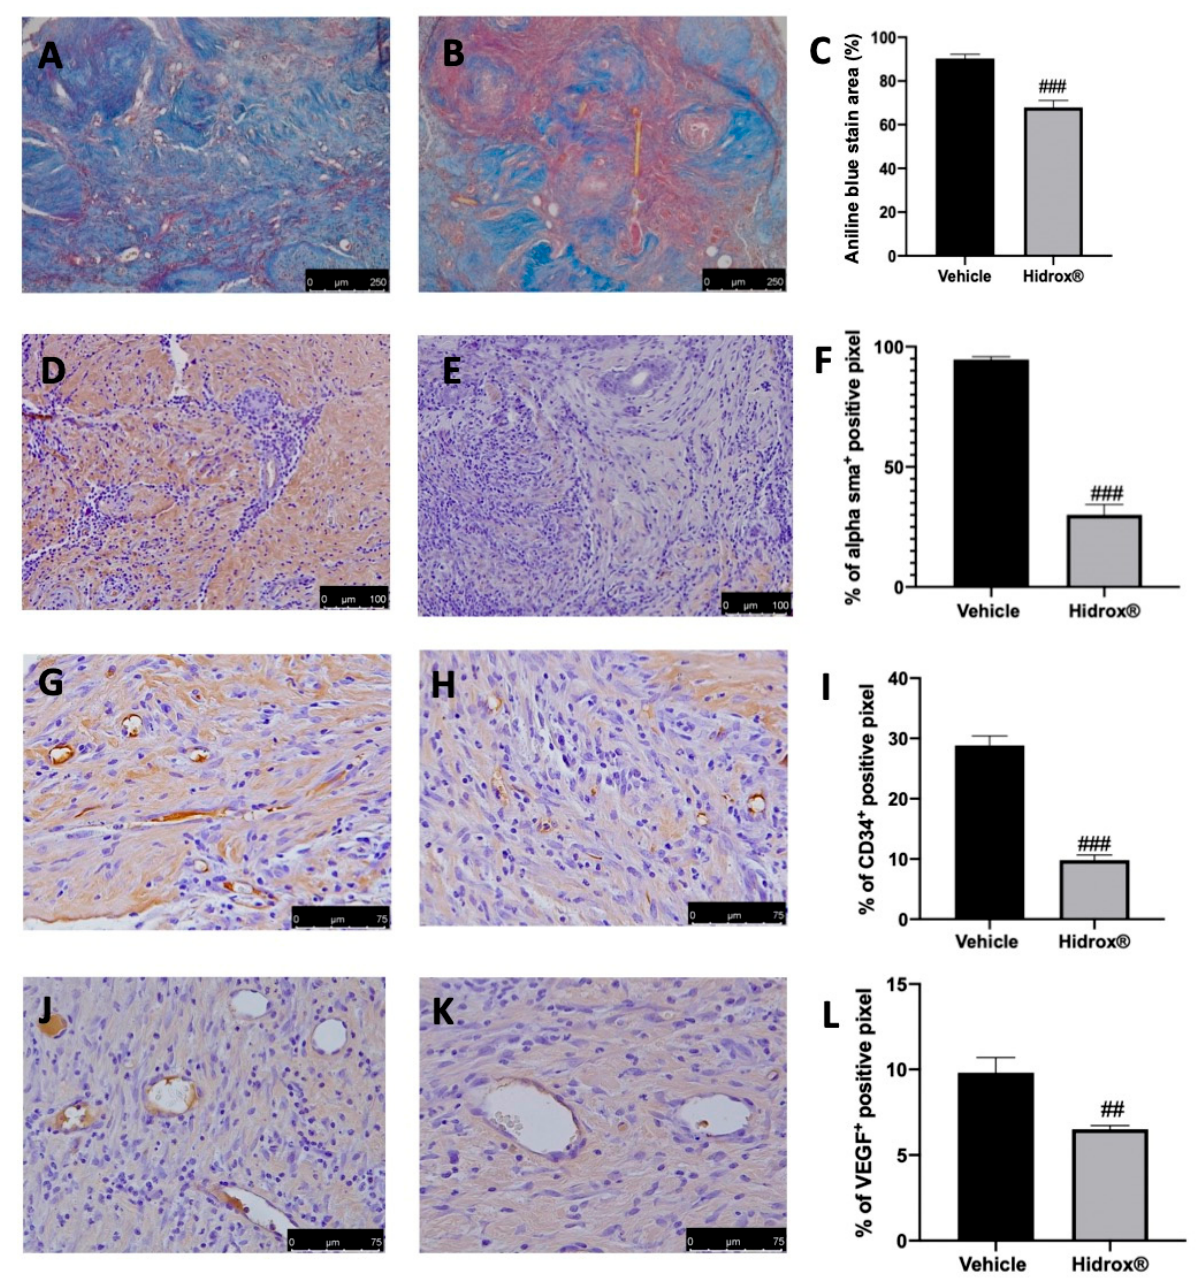
Figure 2. Hidrox ® administration reduced fibrosis and angiogenesis endometriosis-induced: Masson trichrome staining: vehicle ( A ), Hidrox ® ( B ), aniline blue stain area ( C ); immunohistochemical analysis of α -sma: vehicle ( D ), Hidrox ® ( E ), graphical quantification of α -sma expression ( F ); immunohistochemical analysis of CD34: vehicle ( G ), Hidrox ® ( H ), graphical quantification of CD34 expression ( I ). Immunohistochemical analysis of VEGF: vehicle ( J ), Hidrox ® ( K ), graphical quantification of CD34 expression ( L ). For the analyses, n = 5 animals from each group were employed. A p -value of less than 0.05 was considered significant. ## p < 0.01 vs. vehicle, ### p < 0.001 vs. vehicle.